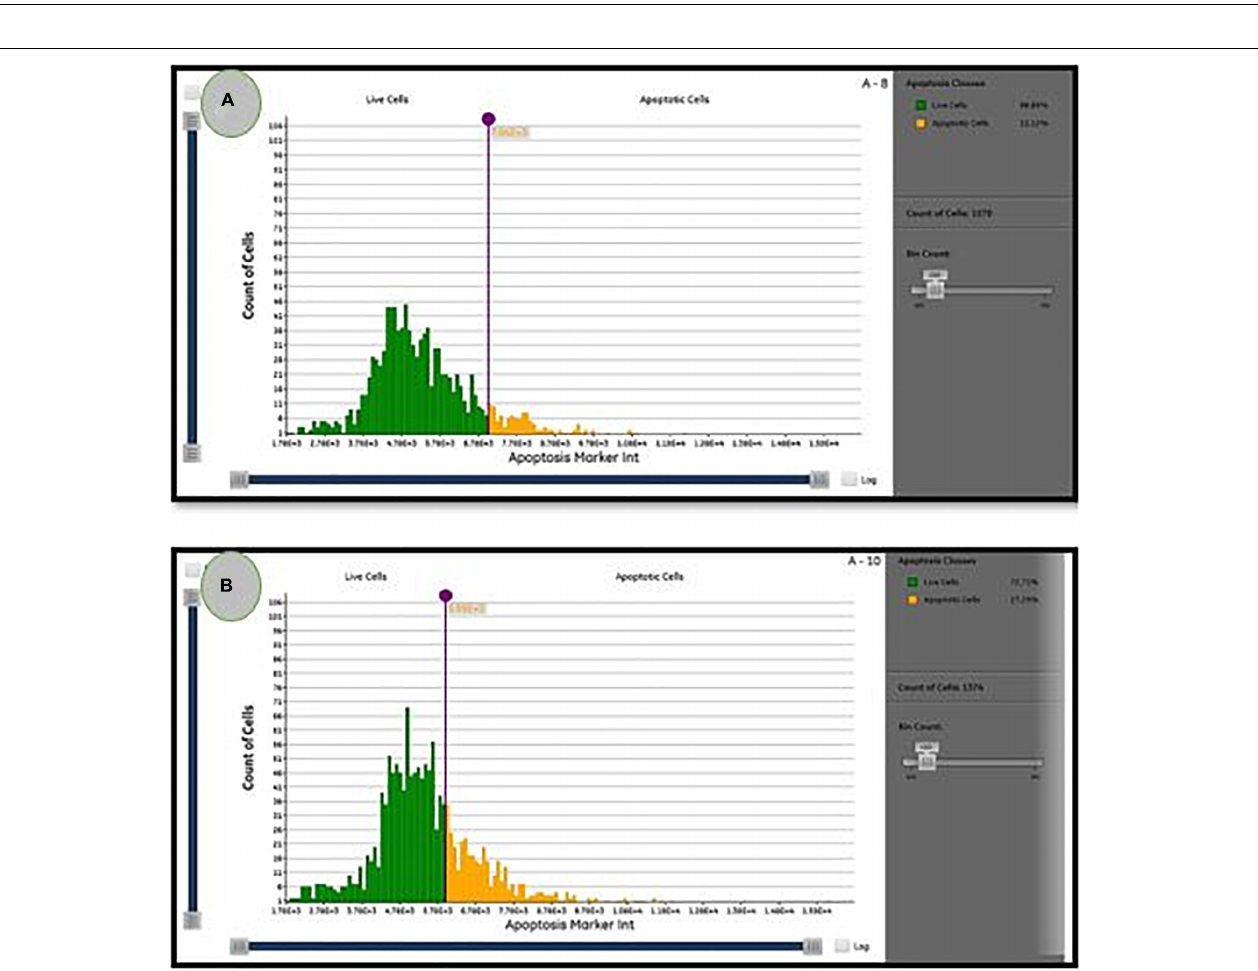
FIGURE 6 | The percentage of live/apoptotic cells using the cytell TM cell imaging system. (A) Control cells; (B) PoPE treated MCF7 cells.